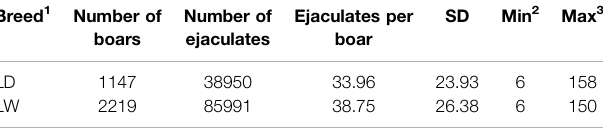
TABLE 1 | Number of boars and ejaculates for two